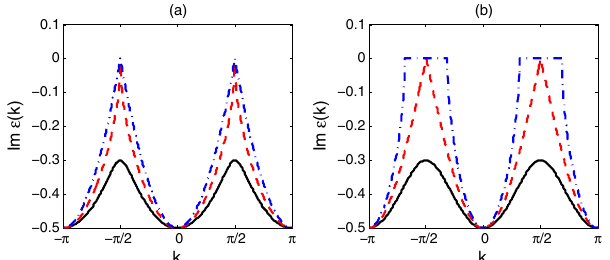
FIG. 4. Imaginary part of ϵ ð k Þ for J 0 ¼ 0 . 1 γ (black solid line), J 0 ¼ 0 . 125 γ (red dashed line), and J 0 ¼ 0 . 15 γ (blue dash-dotted line). (a) J ¼ 0 . 1 γ . (b) J ¼ 0 .